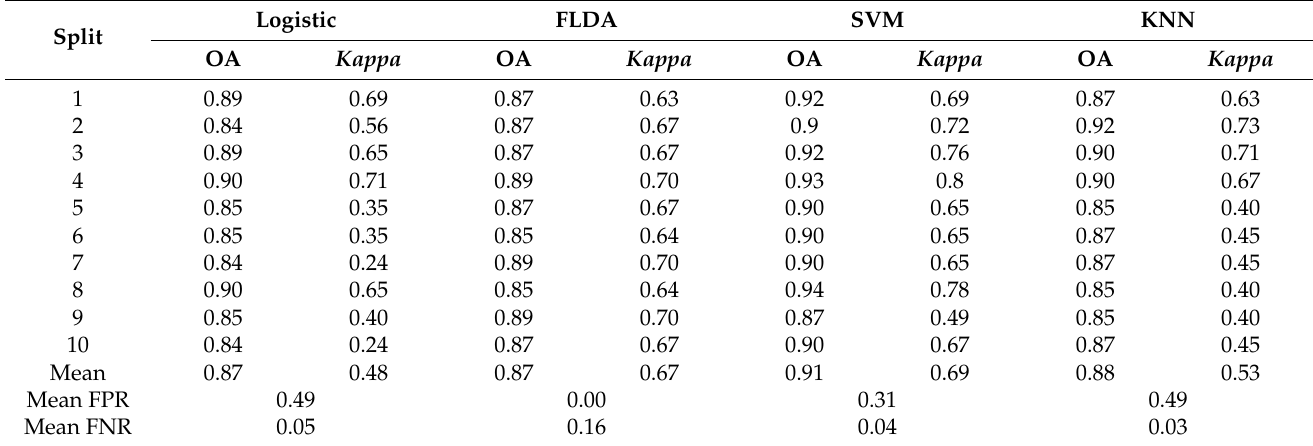
Table 3. Forecasting results of apple ALS under four machine learning algorithms.